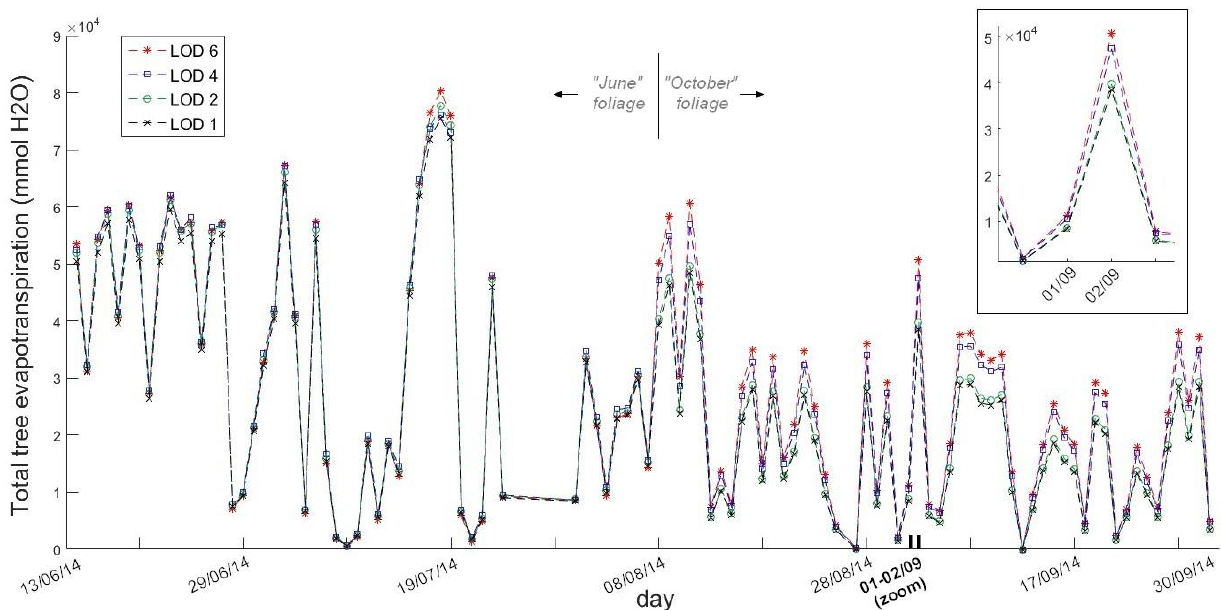
Figure 12. Sensitivity of the evapotranspiration by day depending on the LOD of the tree 3D